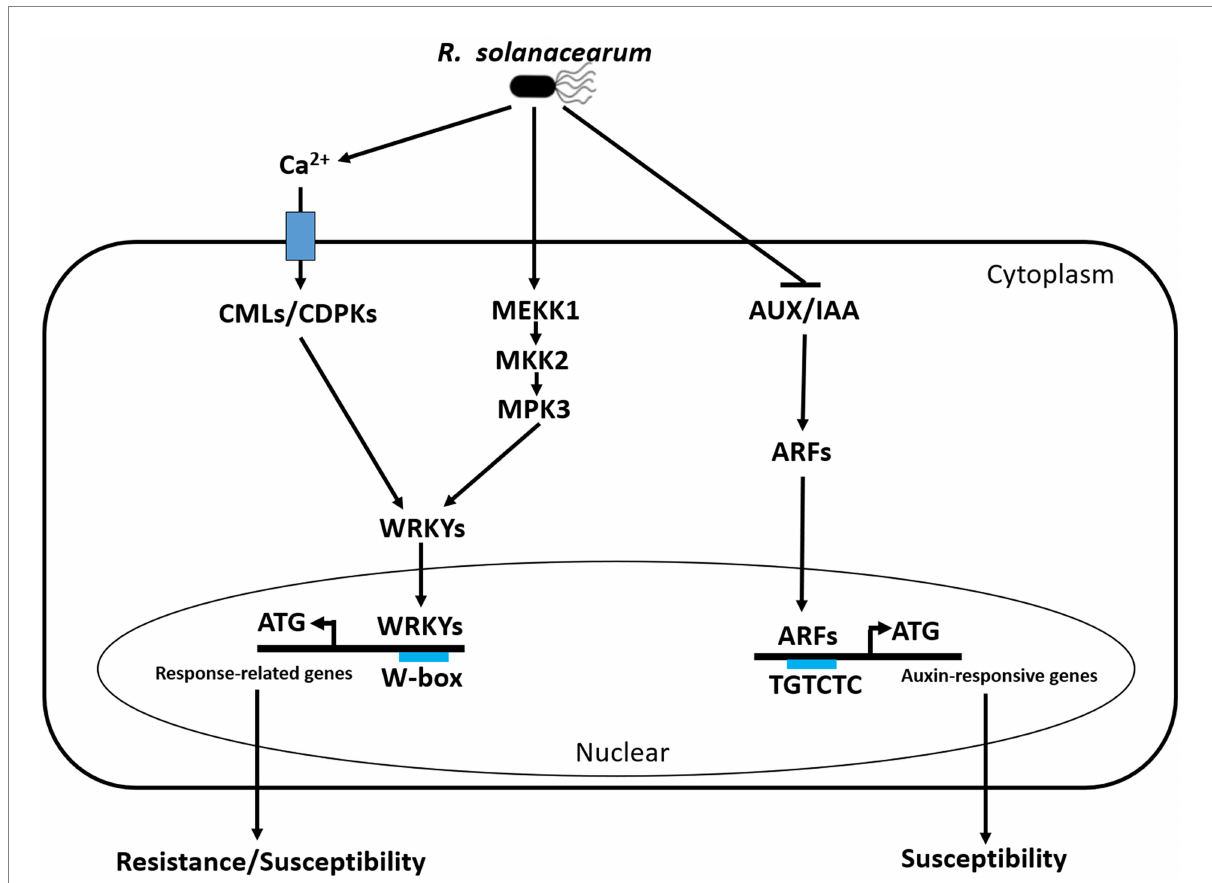
FIGURE 10 Simple schematic diagram of the peanut response to R. solanacearum in our study. Three early molecular events happened in the peanut response to R. solanacearum , including Ca 2+ activate CMLs/CDPKs-WRKY module to regulate the expression of resistance/susceptibility-related genes, auxin signaling was induced by AUX/IAA-ARF module to activate auxin-responsive genes that contribute to susceptibility, and MEKK1- MKK2-MPK3-WRKYs was activated by phosphorylation to induce the expression of resistance/susceptibility-related genes. During the interactions between peanut and R. solanacearum , CMLs are possibly targeted by T3Es, CDPKs are activated by PAMPs, MAPK cascade is induced by PAMPs and T3Es, and auxin signaling is possibly activated by T3Es. CML, calmodulin-like (CML) proteins; CDPK, calcium-dependent protein kinase; WRKY, WRKY transcription factor; MEKK1, MAPK Kinase Kinases 1; MKK2, MAPK Kinases 2; MPK3,